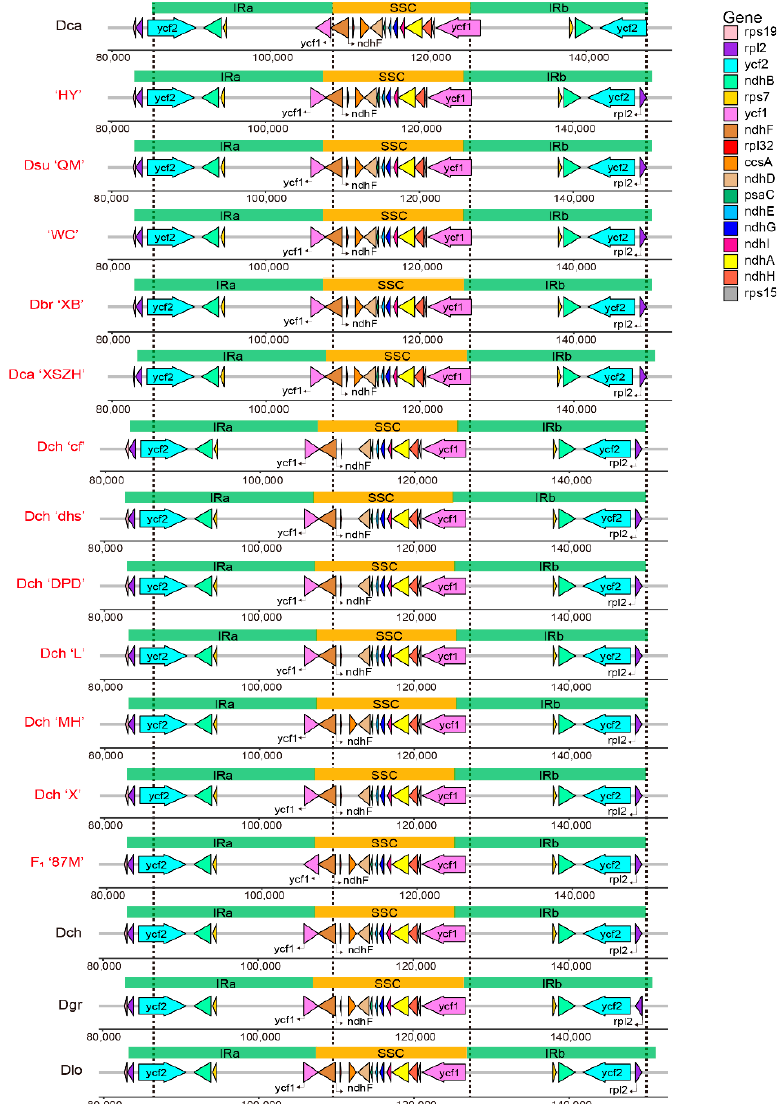
Figure 4. Comparisons of IR regions boundaries among 16 chloroplast genomes in Dianthus . The four dotted lines in the figure represent the boundary position of Dca. The 12 sequenced chloroplast genomes in this study are marked in